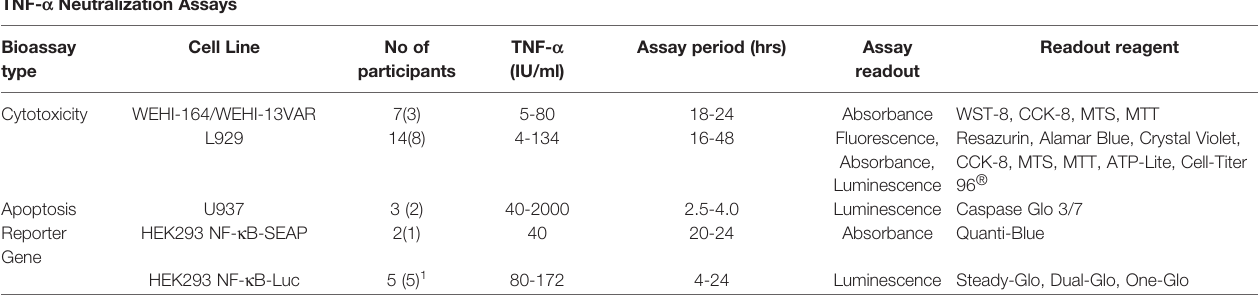
TABLE 5 | Summary of the assays performed in the collaborative study for